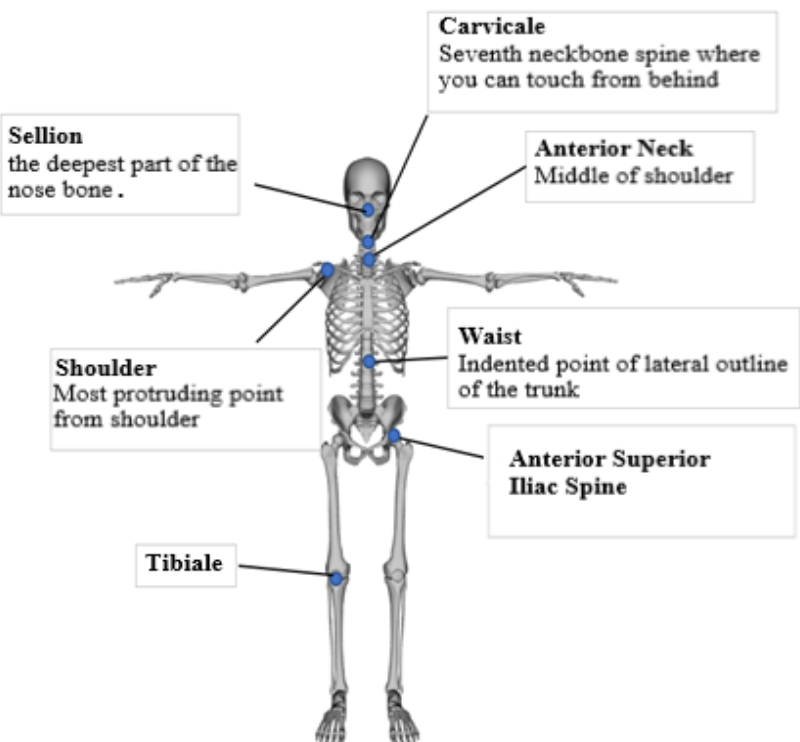
Figure 2. Definition of standard points of the body. Table 3. Definition and derivation method of gait parameters of the lower body (Adapted from Lee et al. 2022 [14], Ergonomic Society of Korea, 2016 [15]).